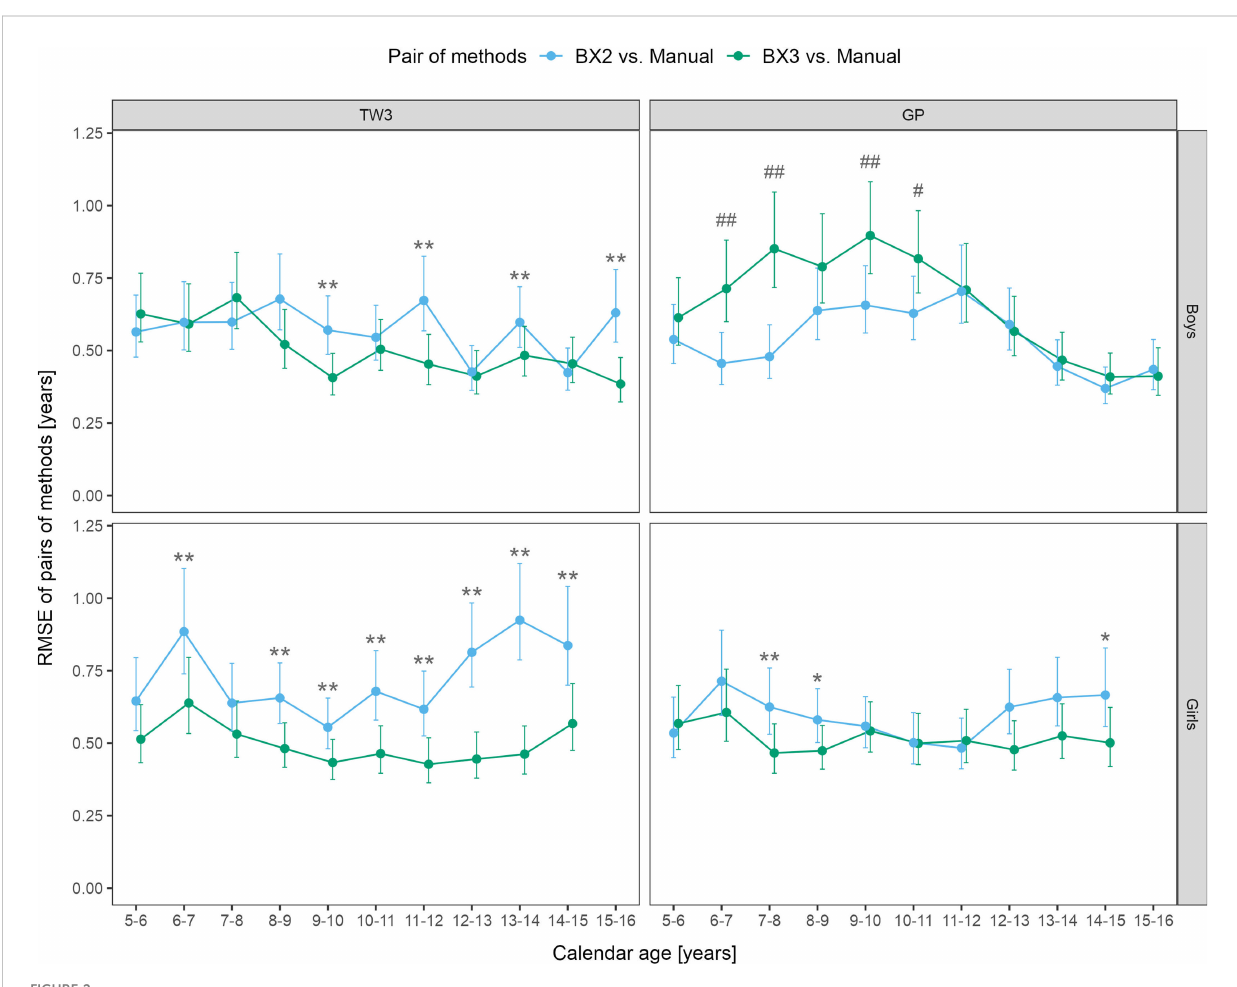
FIGURE 2 Root mean square errors (RMSE) and 95% con fi dence intervals for age and sex speci fi c categories, separately for TW3 and GP methods and for BX2 and BX3 versions. RMSE is given in years. Before (*) and after (**) adjustment for multiple testing, BX3 performs signi fi cantly better, i.e. differs less from the manual assessment, than BX2 at a = 0.05. Before (#) and after (##) adjustment for multiple testing, BX3 performs signi fi cantly worse, i.e. differs more from the manual assessment, than BX2 at a =0.05. TW3, bone age assessment according to Tanner-Whitehouse 3 method; GP, bone age assessment according to Greulich-Pyle method; BX2, BoneXpert version 2.4.5.1.; BX3, BoneXpert version 3.0.3.; MAN, manual bone age